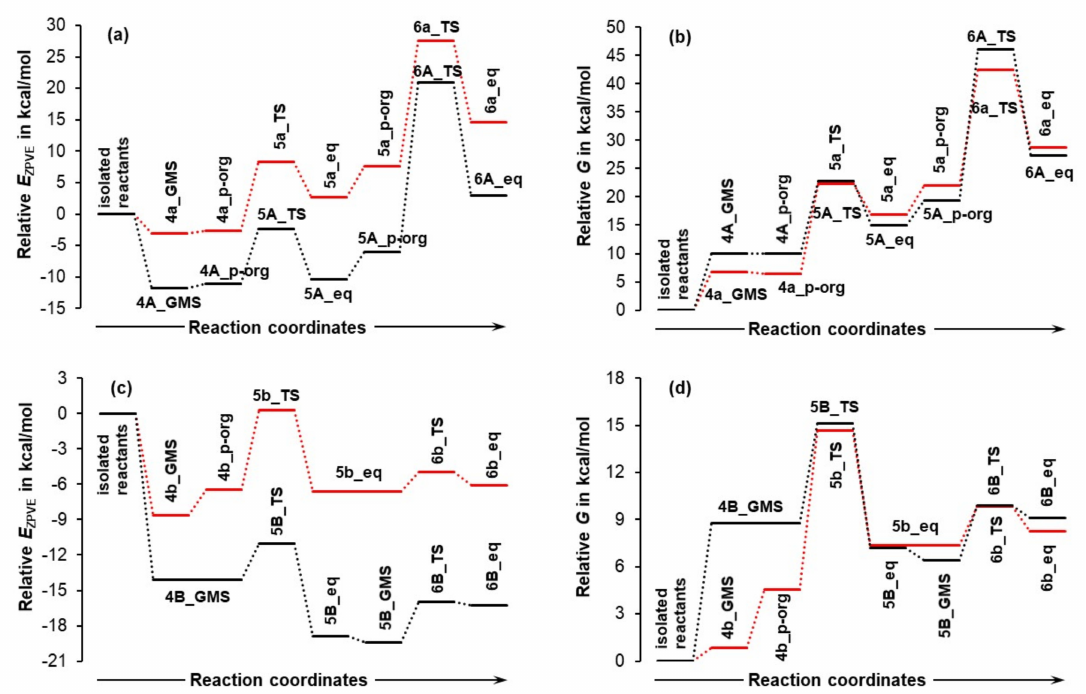
Figure 5. Reaction energy profiles for E ZPVE (parts ( a , c )) and Gibbs free energy ( G , parts ( b , d )) relative to isolated reactants, either ( 1 + 2 , for the implicit solvent model) or ( 1 + 2 + 3 , in the presence of an explicit solvent molecule of DMSO), reaction energy profiles for E ZPVE (parts ( a , c )), and Gibbs free energy ( G , parts ( b , d )). Data up to the second proton transfer 6a / 6b and 6A / 6B are presented. The suffix p-org, TS, and eq represent pre-organized, transition state, and equilibrium structures,